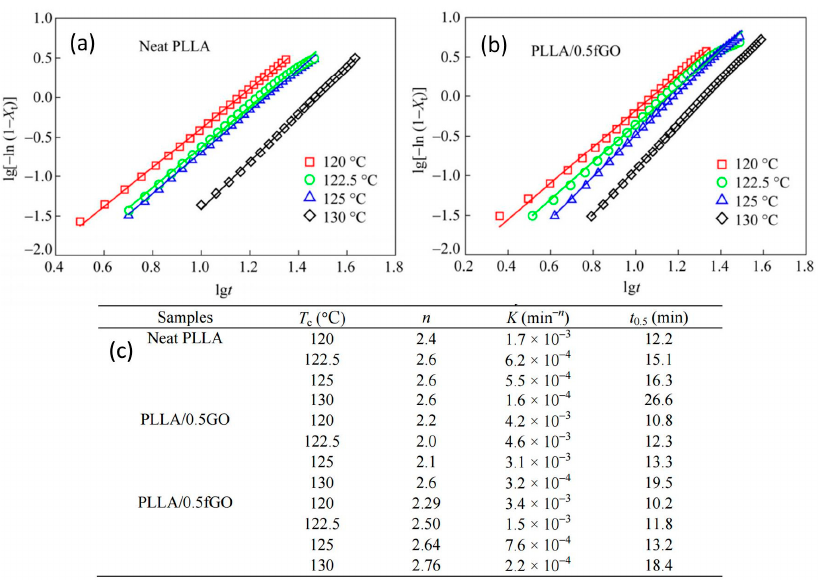
Figure 12. Avrami plots of neat PLLA ( a ), and PLLA/0.5fGO ( b ). Isothermal crystallization kinetics parameters of neat PLLA, PLLA/0.5GO and PLLA/0.5fGO obtained by Avrami fit are tabulated in